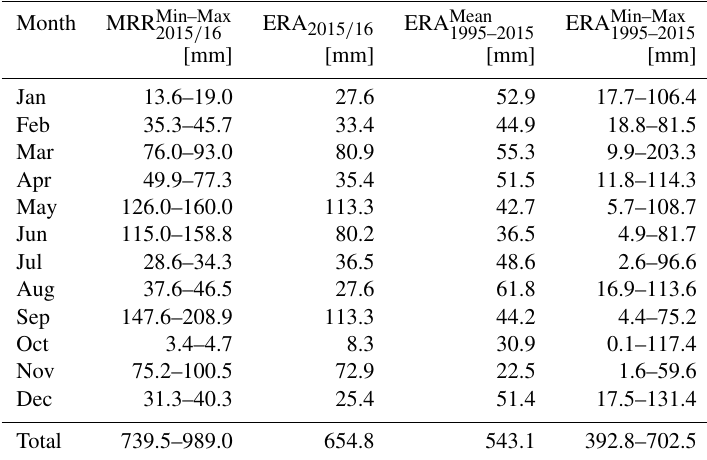
Table 3. Monthly accumulated precipitation of snow (mm of liquid water equivalent) from the MRR, using the locally optimized Z – S relation and the confidence interval of its parameters, and ERA-Interim data. The mean, minimum, and maximum snowfall of each month for ERA-Interim data from 1995 to 2015 are also shown.